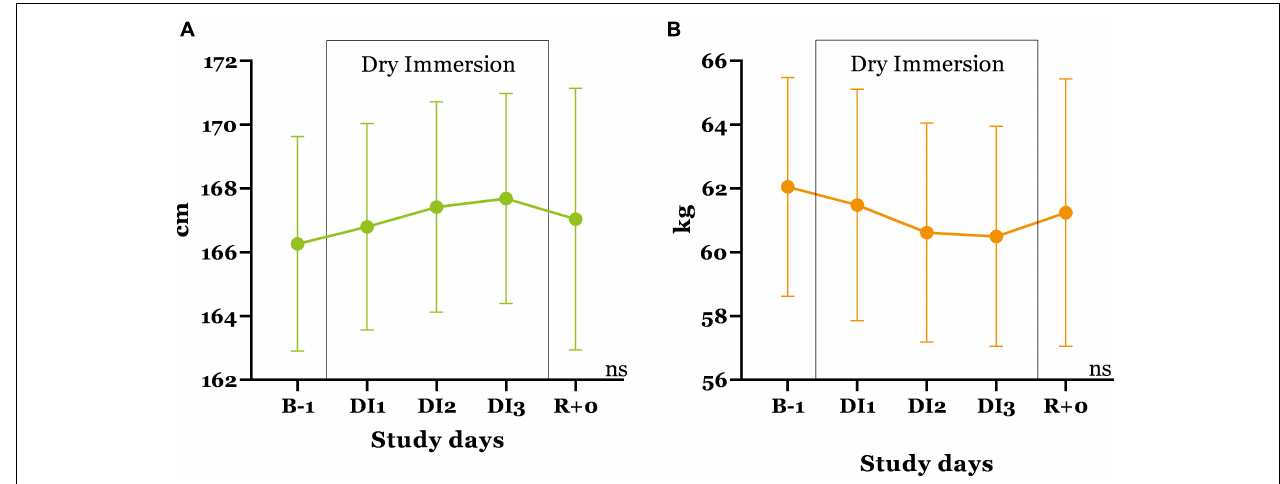
FIGURE 5 | Changes in the height (A) and body weight (B) of the subjects during the 3-day immersion exposure. Mean ± SEM.